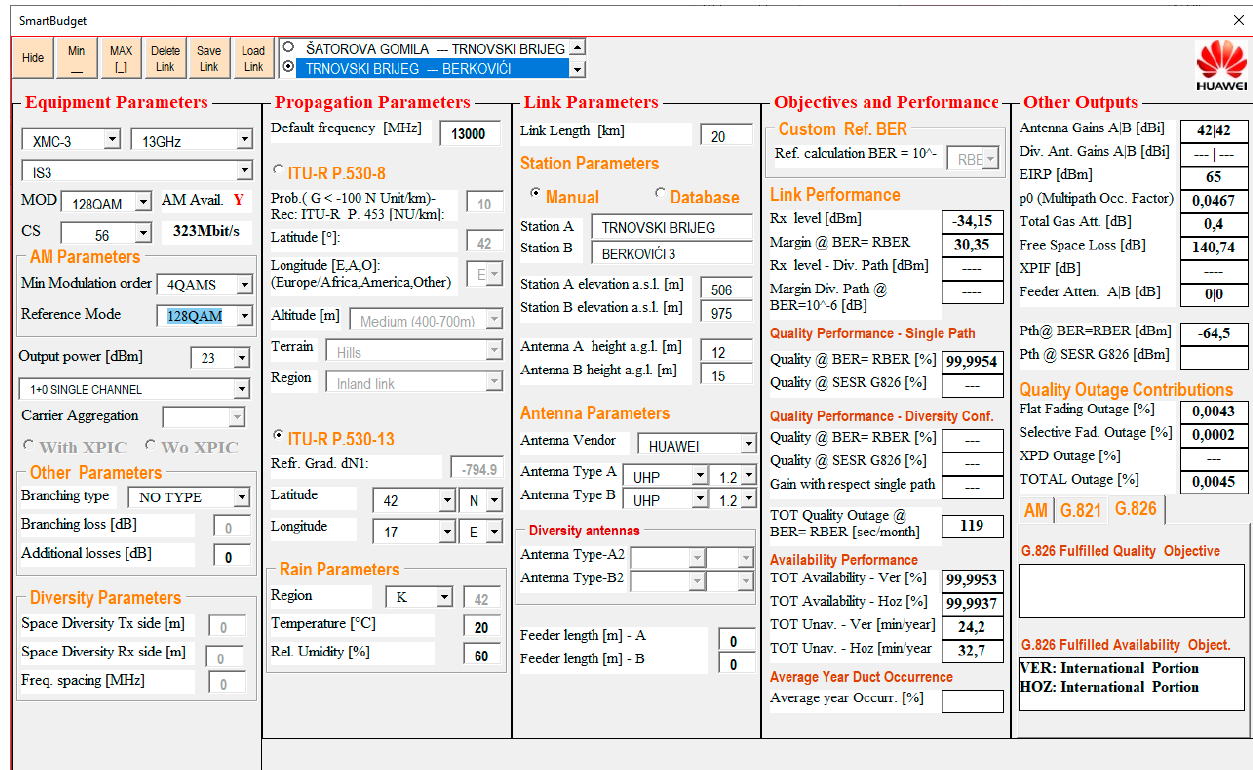
Figure 12. Prediction for the second RR section; 128 QAM, 323 Mb/s.